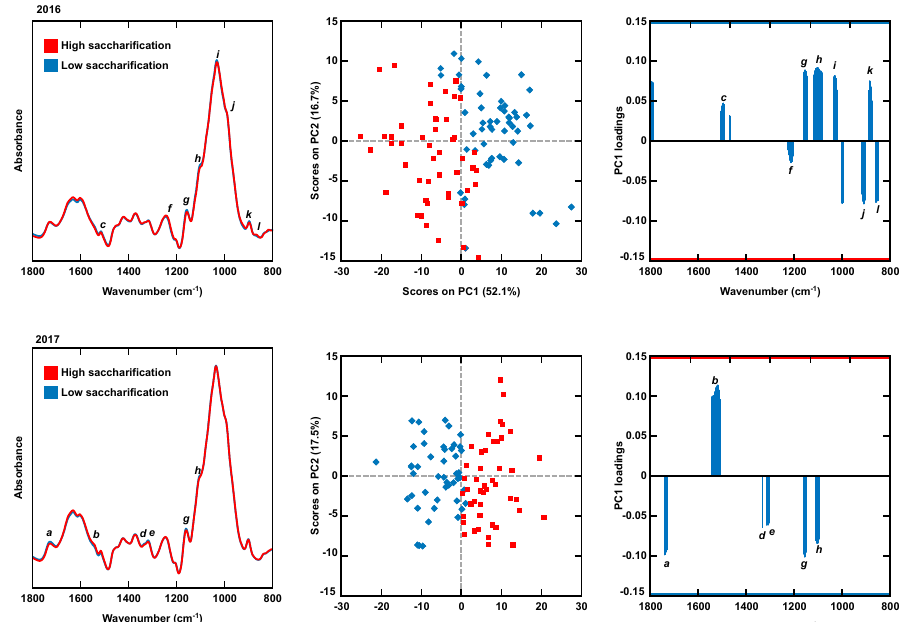
Figure 1. Mean FTIR-ATR spectra of maize lignocellulosic biomass from high and low saccharification yield groups, harvested in 2016 and 2017, in the range 1800–800 cm − 1 . Score plot of the PCA model calculated based on highly significantly different variables ( p ≤ 0.001), as calculated by t-tests (208 variables for 2016 and 121 variables for 2017). The PC loadings plots indicate spectral regions ( a – l ) that are positively or negatively correlated to PC1, along which group separation occurred. Table 2 shows the wavenumbers corresponding to each region. Table 2. Assignment of relevant FTIR-ATR absorption bands characteristic of maize cell wall biomass.